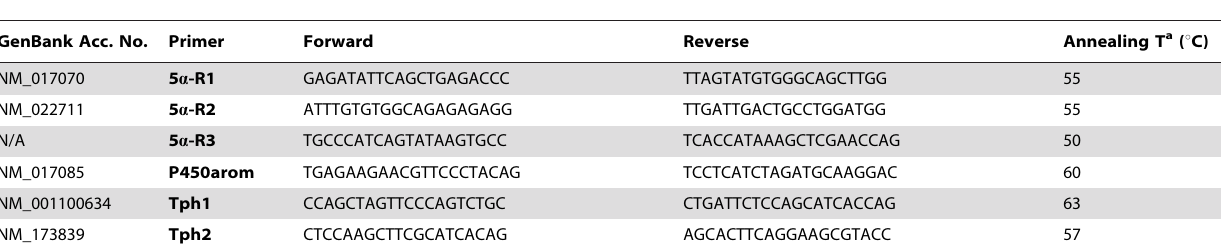
Table 1. Primer sequences (5 9 -3 9 ) and PCR conditions for RT-PCR analysis.